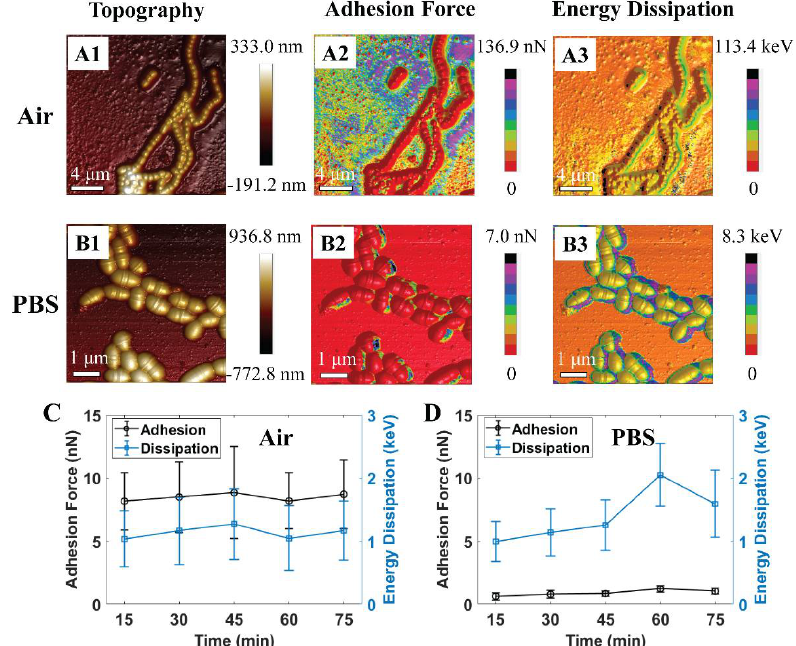
Figure 2. Schematic illustrations of 3D atomic force microscopy (AFM) morphologies of S. mutans